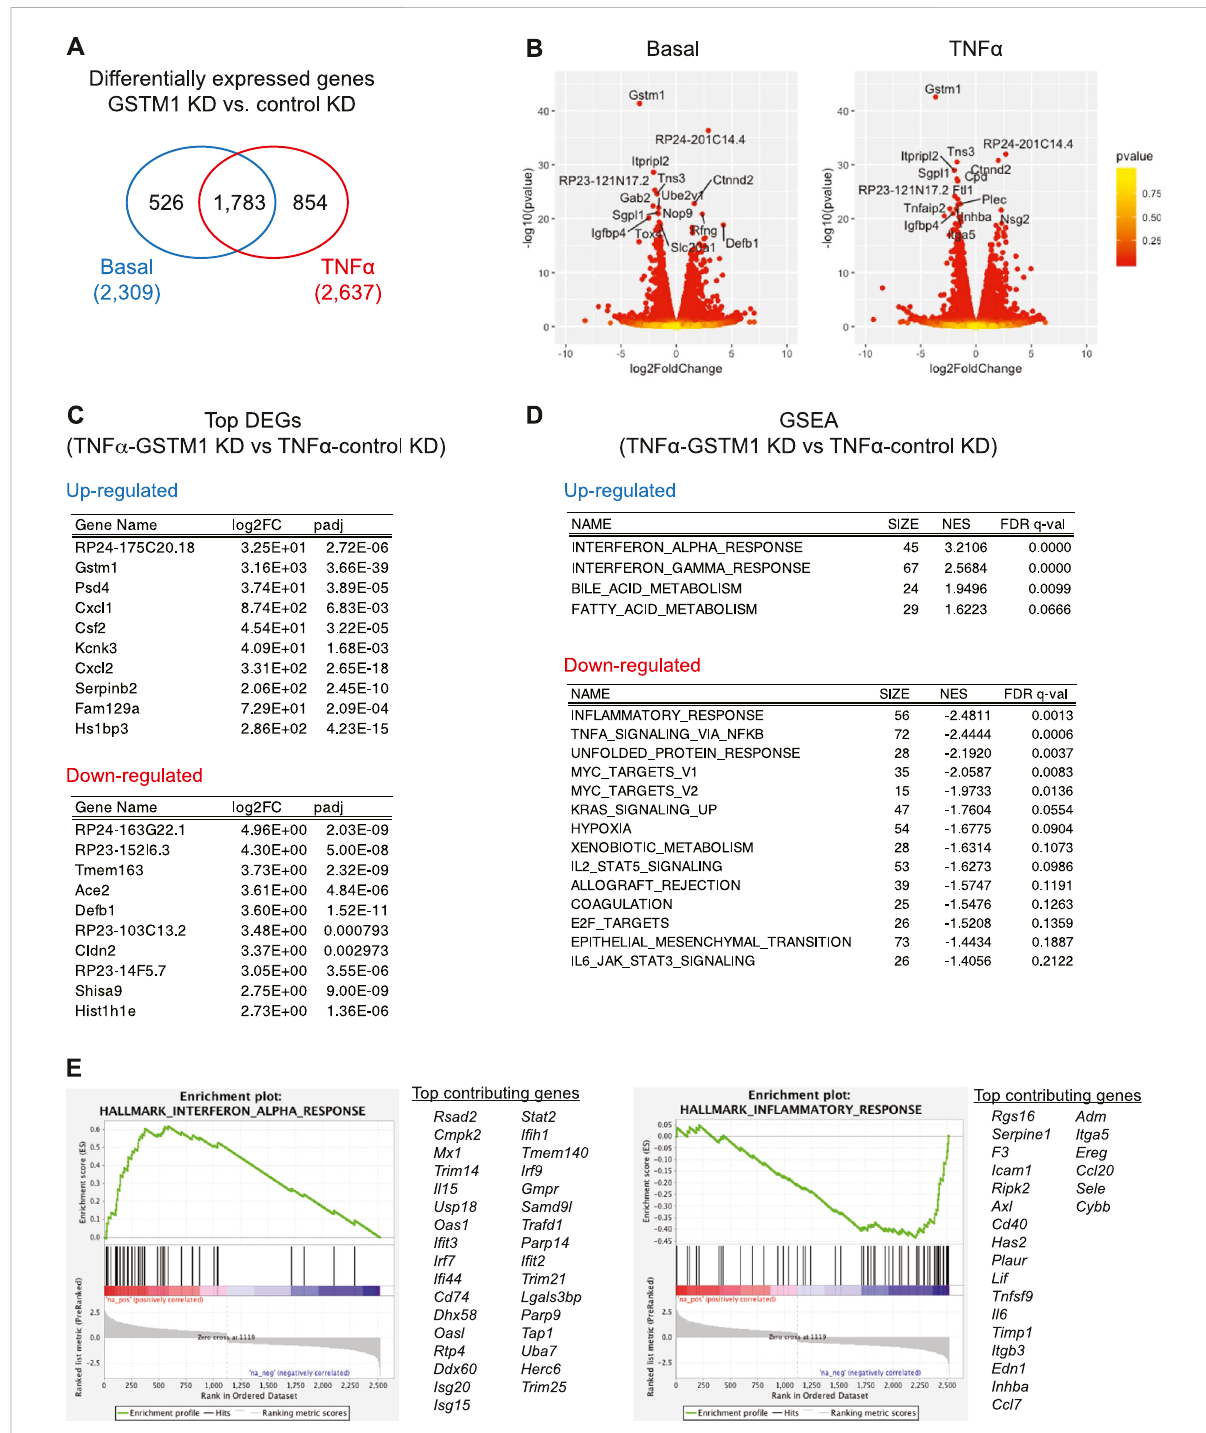
FIGURE 1 RNA-seq analysis of altered gene expression in cultured astrocytes with reduced GSTM1 expression. Primary mouse cortical astrocytes expressing Gstm1 ornon-silencing control shRNAconstructs[GSTM1knockdown(KD)orcontrolKD] werestimulated withTNF- α (50 ng/ml)for6 h and their mRNA expression was analyzed by RNA-seq analysis (n = 2 biological replicates per group). (A) . Venn diagram of differentially expressed genes (DEGs) inGSTM1 KDor control KD astrocytes. (B) .Volcano plots for DEGs betweenGSTM1 KD and control KD astrocytes with or without TNF- α stimulation. (C) . Top DEGs in GSTM1 KD astrocytes in response to TNF- α . (D) . Gene set enrichment analysis (GSEA) for DEG in GSTM1 KD astrocytes upon TNF- α stimulation. (E) . Representative GSEA plots for interferon alpha responses and in fl ammatory responses (derived from Molecular Signature database, hallmark gene sets) and their core enrichment